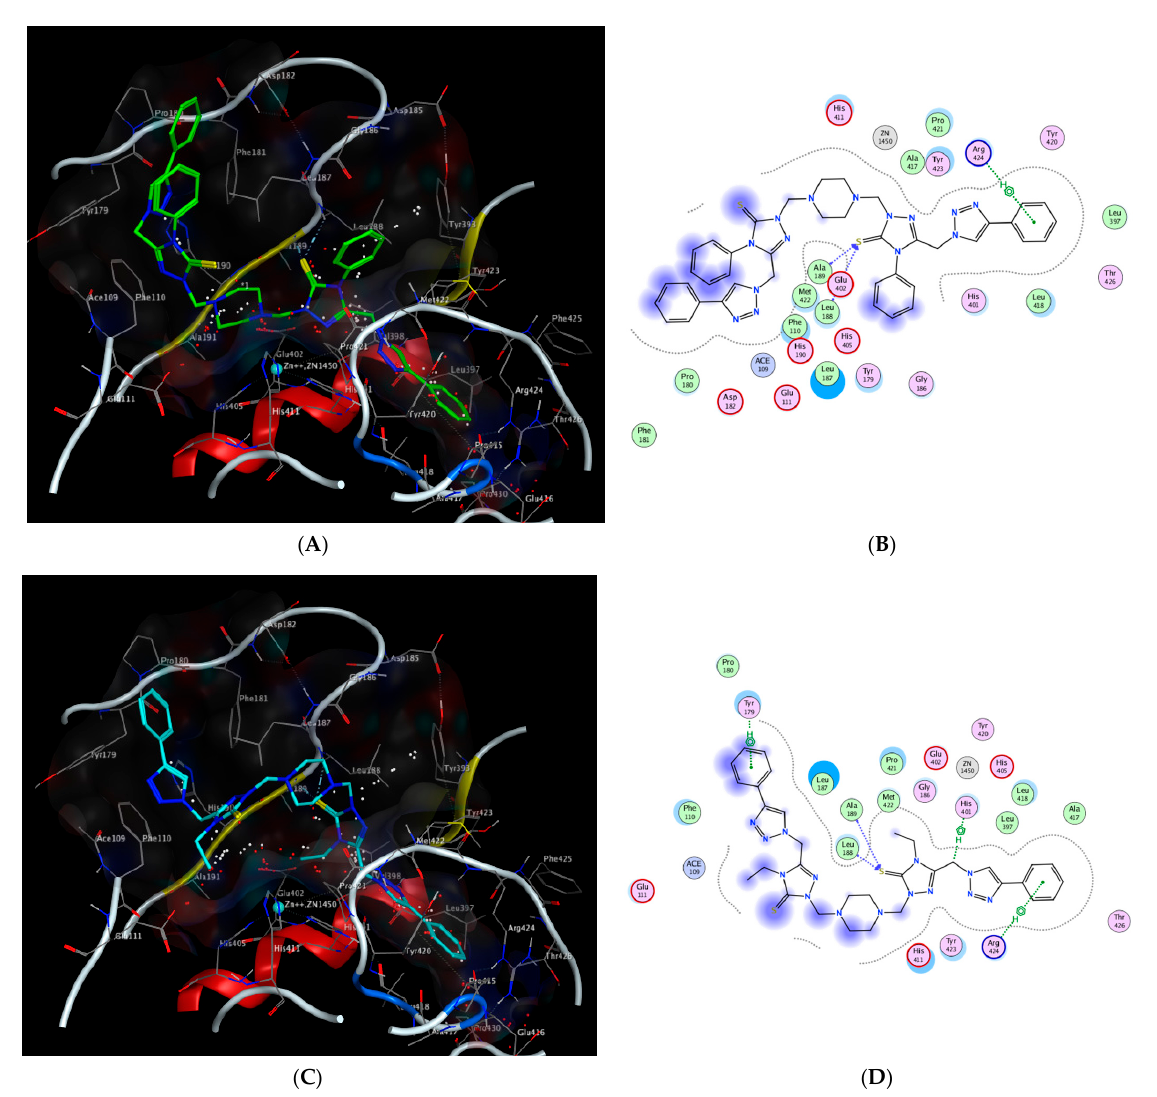
Figure 6. ( A ) Three-dimensional binding mode of 15 (green sticks), ( B ) 2D binding mode of 15 , ( C ) 3D binding mode of 16 (cyan sticks), and ( D ) 2D binding mode of 16 in MMP-9 catalytic (PDB code: 1GKC [75]).